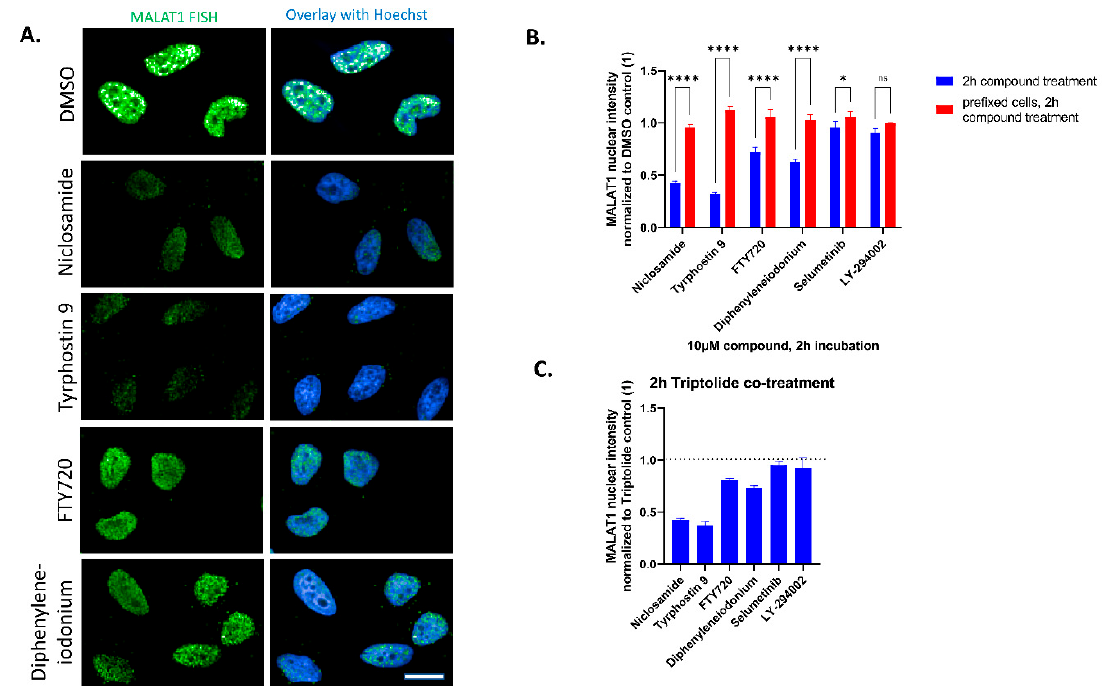
Figure 3. ( A ): Hela stained for MALAT1 lncRNA by fluorescence in-situ hybridization after treatment with DMSO control or HTS hits at 10 µM and 2 h incubation time. Nuclei are stained by Hoechst. Scale bar ~10 µm. ( B ): Quantification of nuclear MALAT1 staining compared with pre-fixed cells after 2 h compound addition. Highly significant effects compared to each pre-fixed control are detected for four of the compounds. Bars show mean with SD. **** p value < 0.0001; * p value < 0.1; NS = not significant. ( C ): Quantification of nuclear MALAT1 staining after co-treatment with 10 µM of the transcription inhibitor Triptolide and 10 µM of HTS hits. Data normalized to Triptolide/DMSO control (1). Bars show mean with SD.